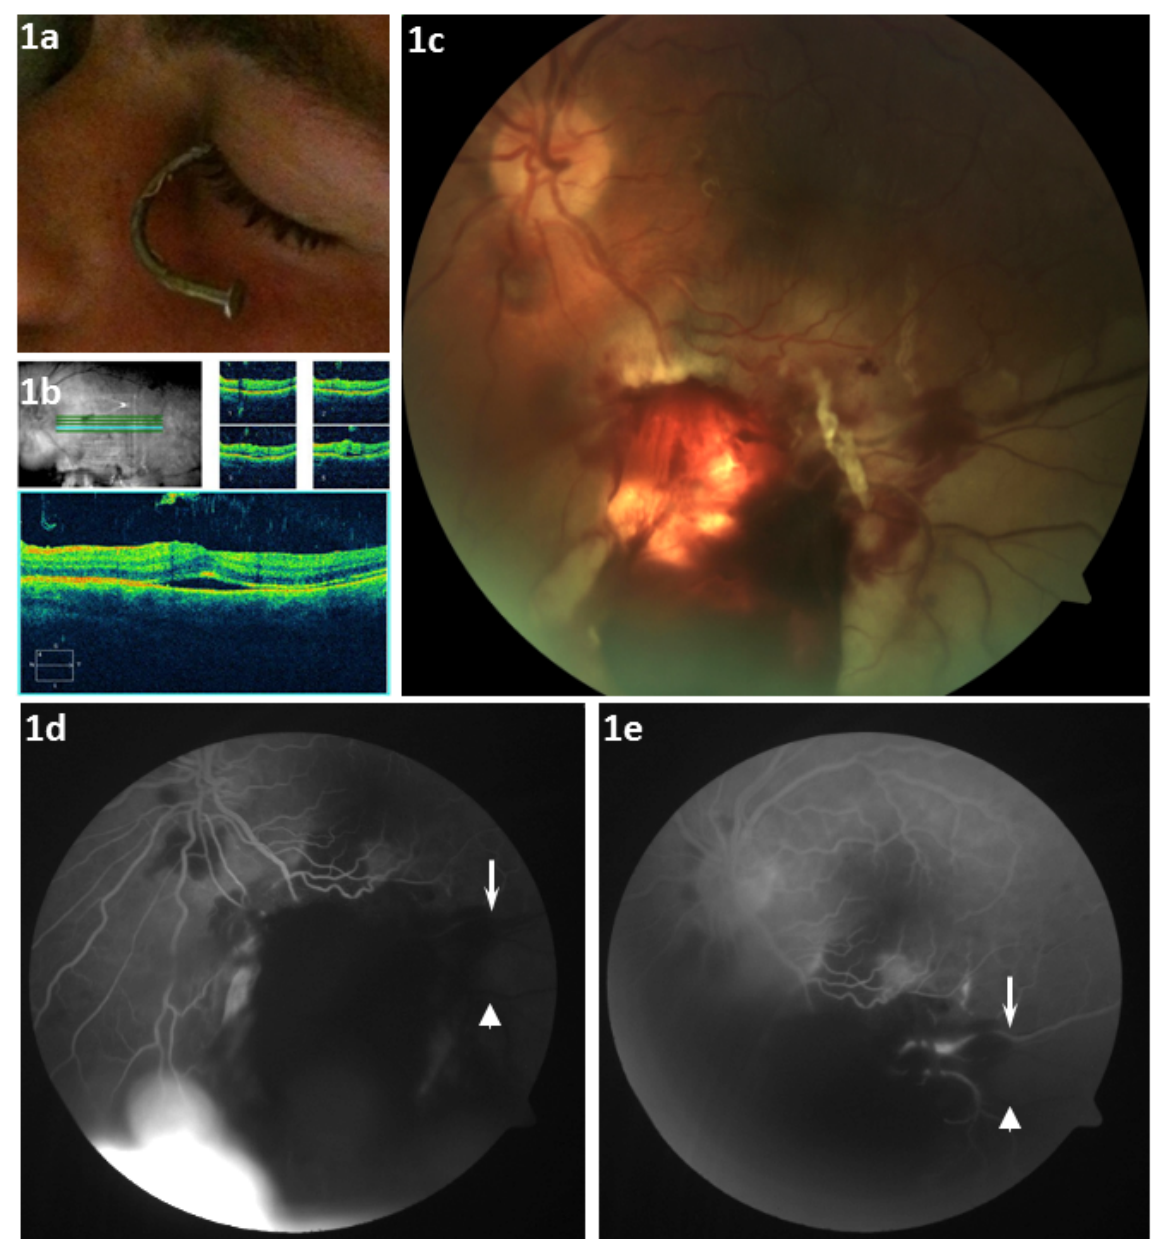
Figure 1: Initial presentation and subsequent fundus photo and OCT 3 d post